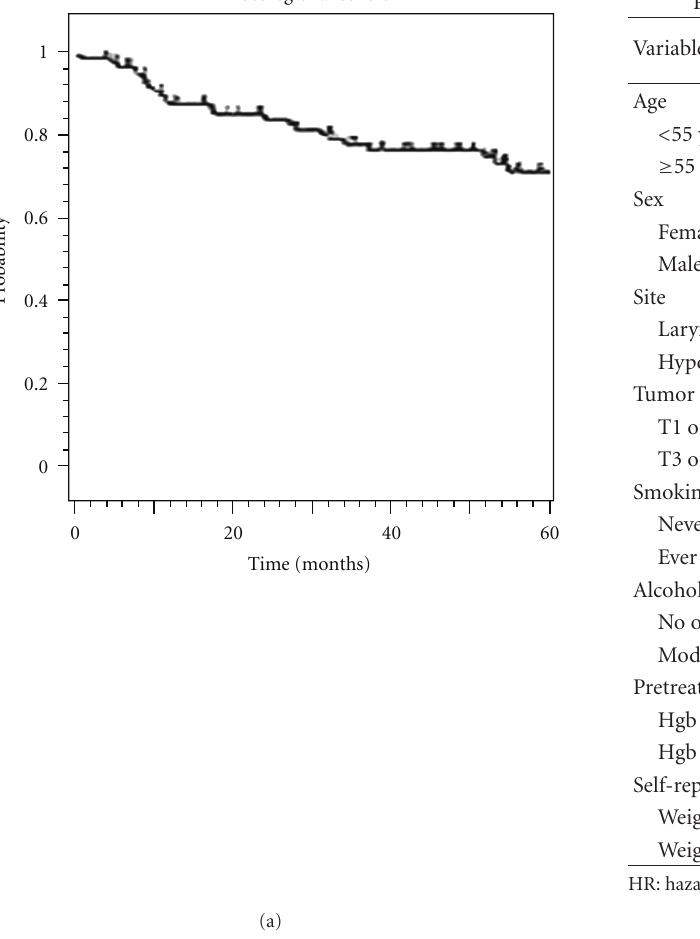
Figure 2: (a) Kaplan-Meier depiction of locoregional control for all patients, (b) univariate analysis of clinical characteristics potentially associated with locoregional